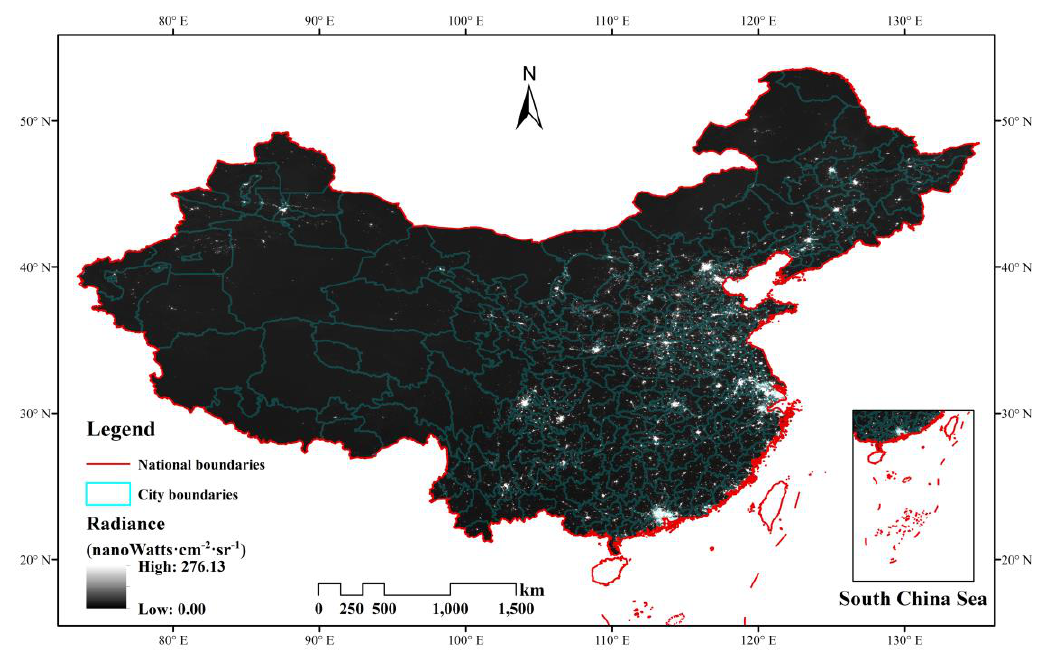
Figure 1. Study area and nighttime light in 2013.